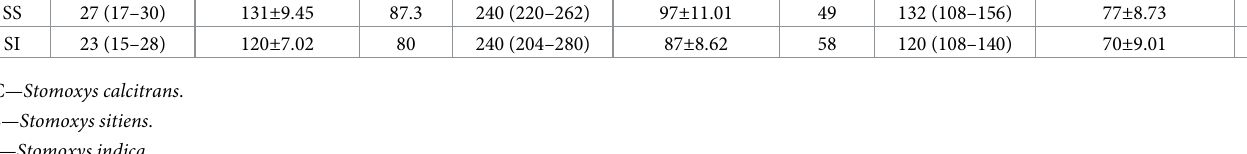
Table 3. Quantitative indicators of the development of immature flies using combined incubation parameters in a single life cycle. Species Stage of development Eggs (32 о , 90% RH) Larvae (27 о , 70% RH) Pupae (27 о , 70% RH) Period, hours/ Number of % Period, hours/ Number of % Period, hours/ Number of imago % mean hatched/mean hatched mean pupated/mean pupated mean emerged/mean